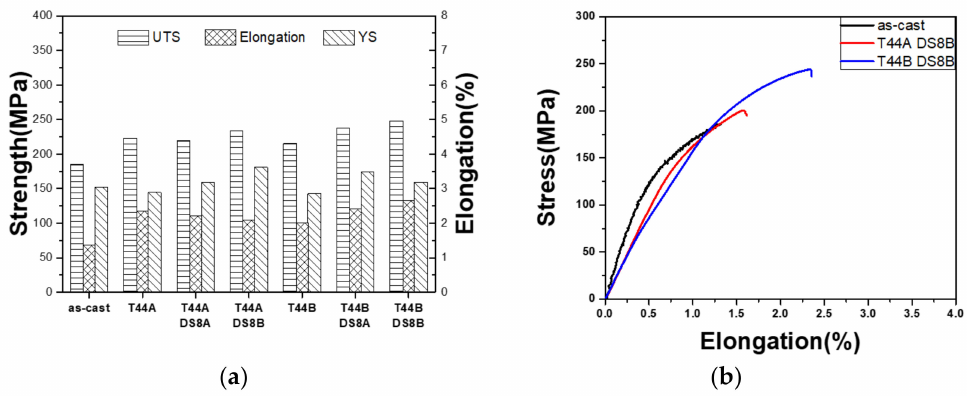
Figure 9. Tensile properties of the alloys after various solution treatments: ( a ) mechanical data at each heat treatment condition; UTS (ultimate tensile strength) elongation, YS (yeild strength) and ( b ) flow curves of typical sample